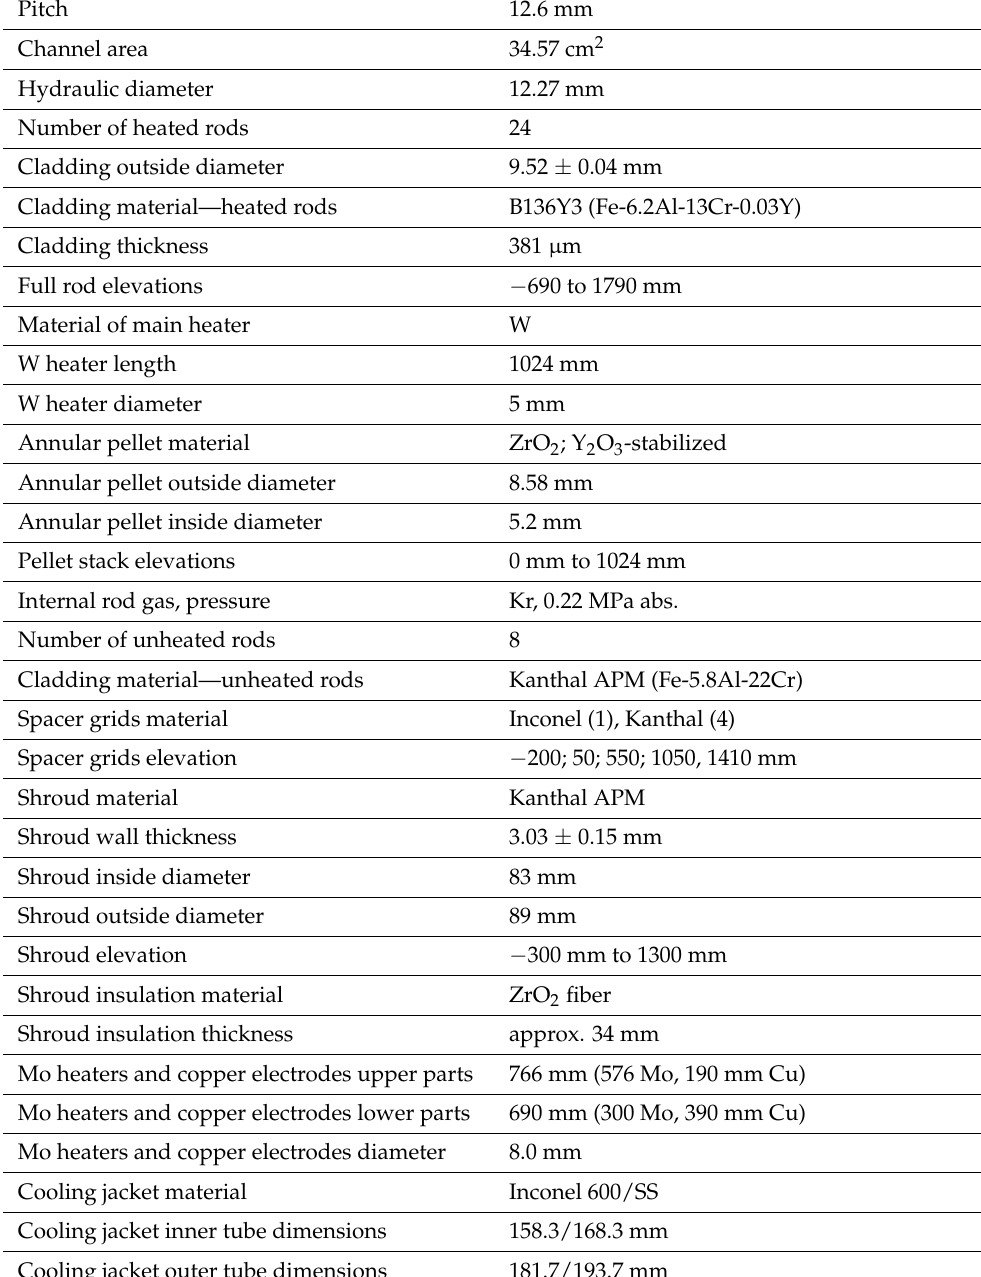
Table 1. Parameters of the QUENCH 19 test bundle